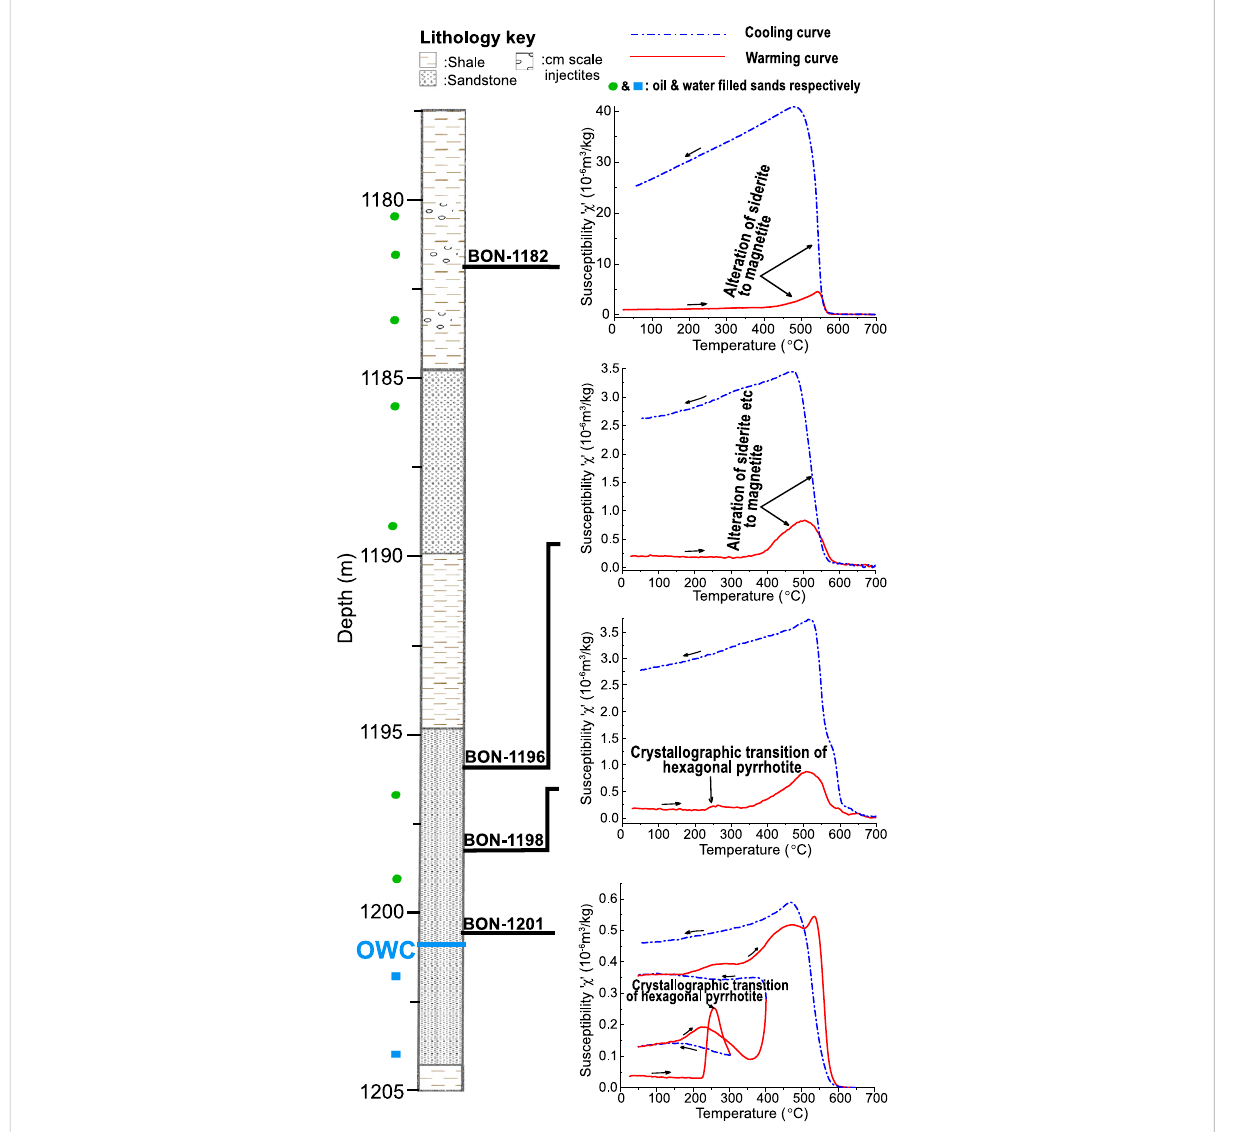
FIGURE 5 Example results from the HT- χ measurements carried out on the Bonneville samples. The magnetic minerology of the “ main ” oil leg is dominated by siderite. The oil-water region presents a diminished siderite signature and the presence of hexagonal pyrrhotite. Note that the oil- water contact (OWC) marked is as obtained via well logs and pressure